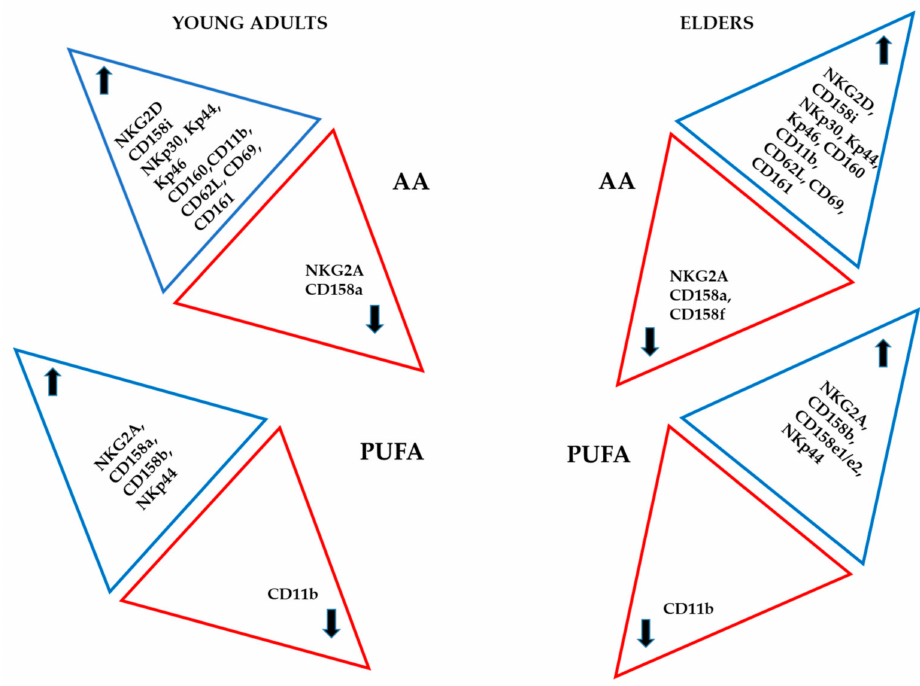
Figure 6. Schematic illustration of the e ff ect of arachidonic acid (AA) and PUFA, polyunsaturated (PUFA) w3 fatty acids (DHA and EPA) on the expression of di ff erent antigens in NK cells from healthy young adults and healthy elder volunteers. The arrows indicate an increase or decrease of the antigens. AA corresponds to arachidonic acid, and w3 corresponds to DHA and